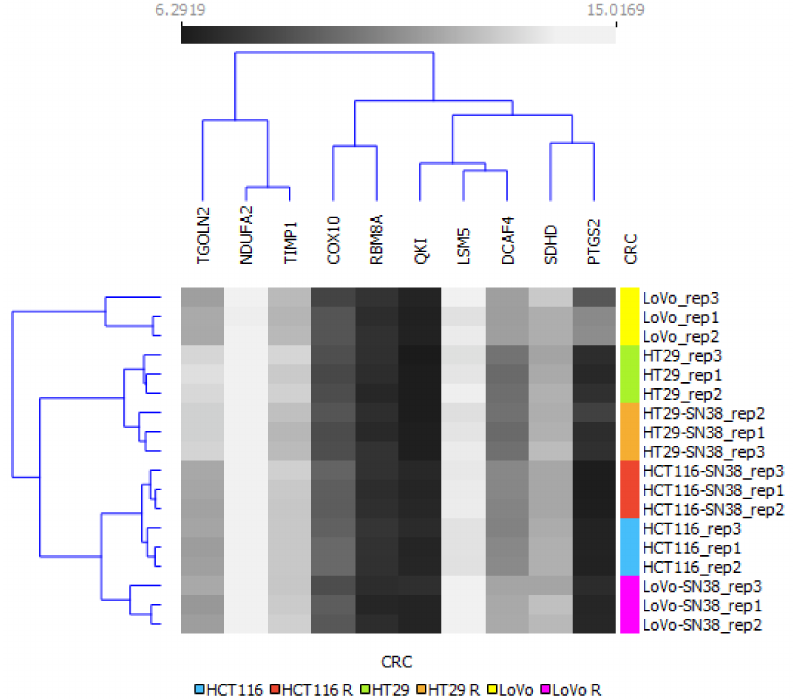
Figure 5. Hierarchical clustering analysis of CRC cell lines using mRNA expressions of top network- ing DEGs from FOLFIRI-resistant patient cohort. The expression values between corresponding irinotecan-resistant and parental CRC cell lines are presented in grayscale; black represents low and white represents high expression values (6.29–15.02). A bidirectional hierarchical clustering heat map was visualized using the Orange data visualization